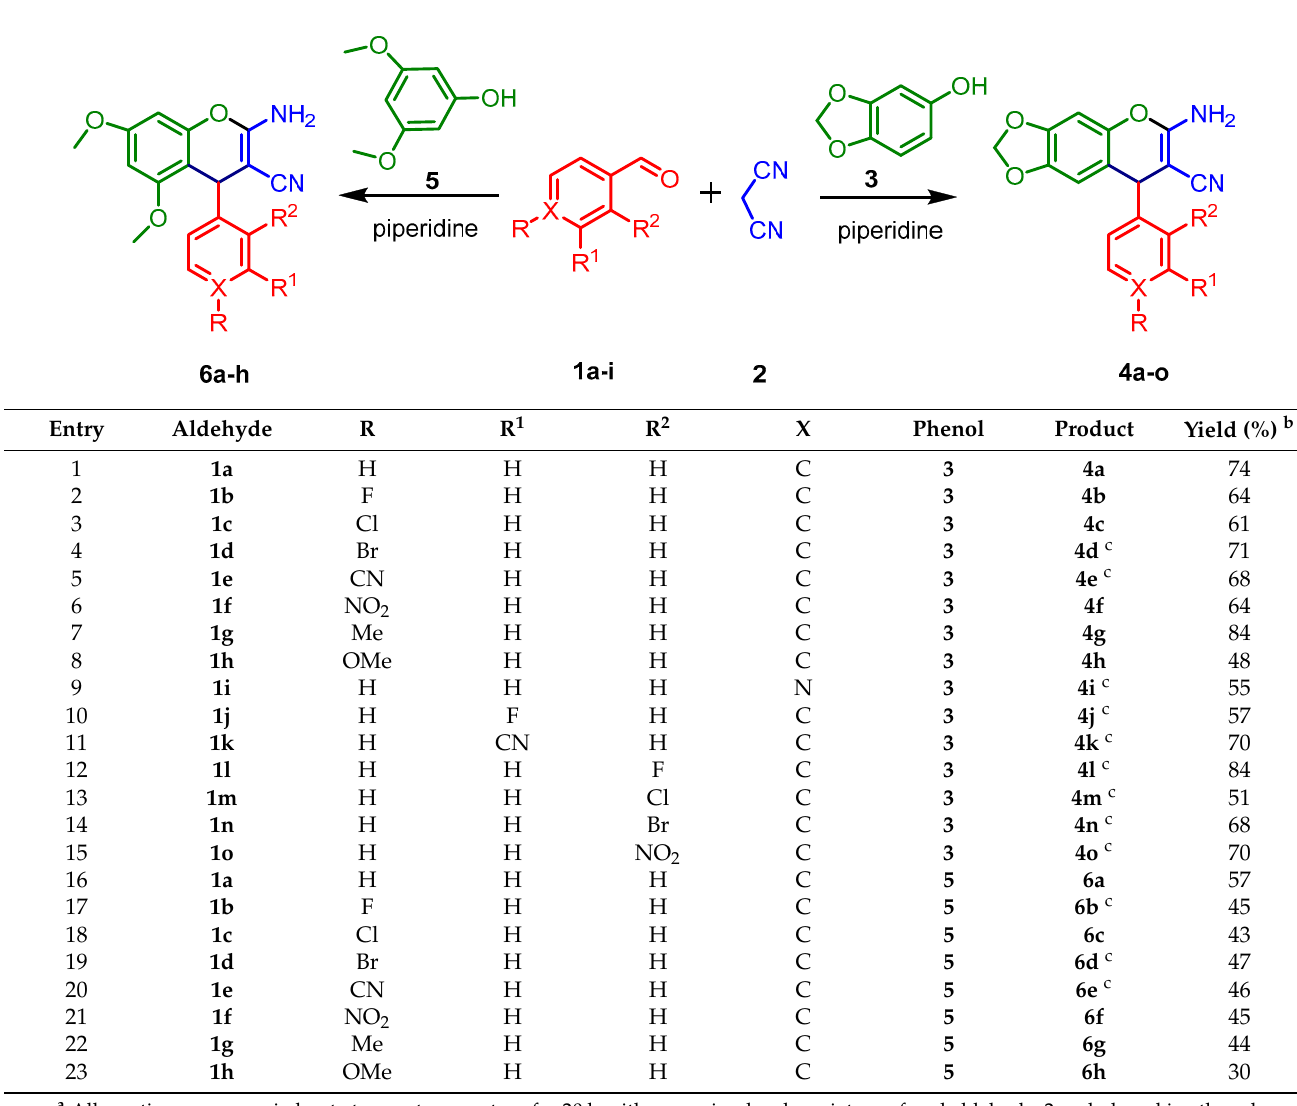
Table 2. Synthesis of 2-amino-3-cyano-4 H -chromenes 4a–o and 6a–h a .